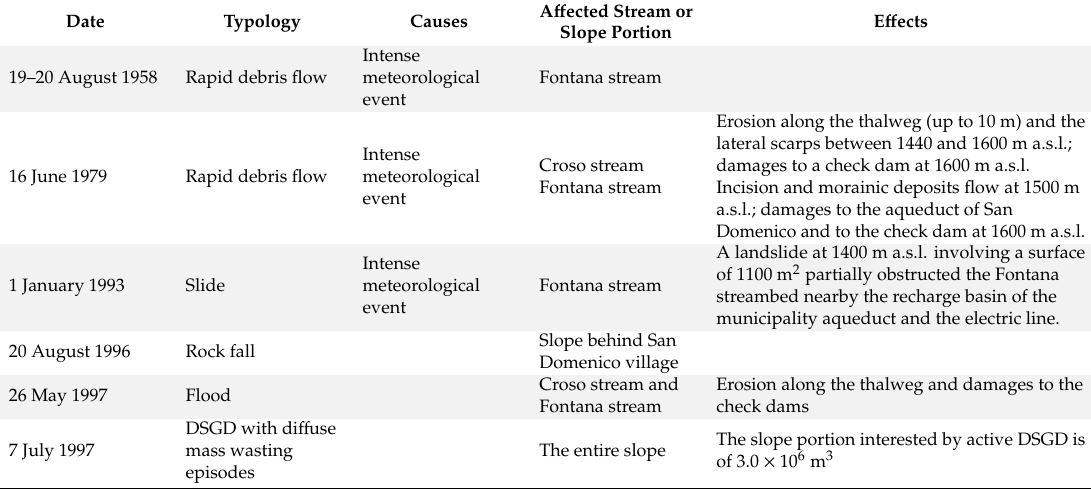
Table 3. Hydrogeological instability and mass wasting events affecting the Croso stream and the tributary Fontana stream, located immediately westerly to San Domenico village, before the 2000 event